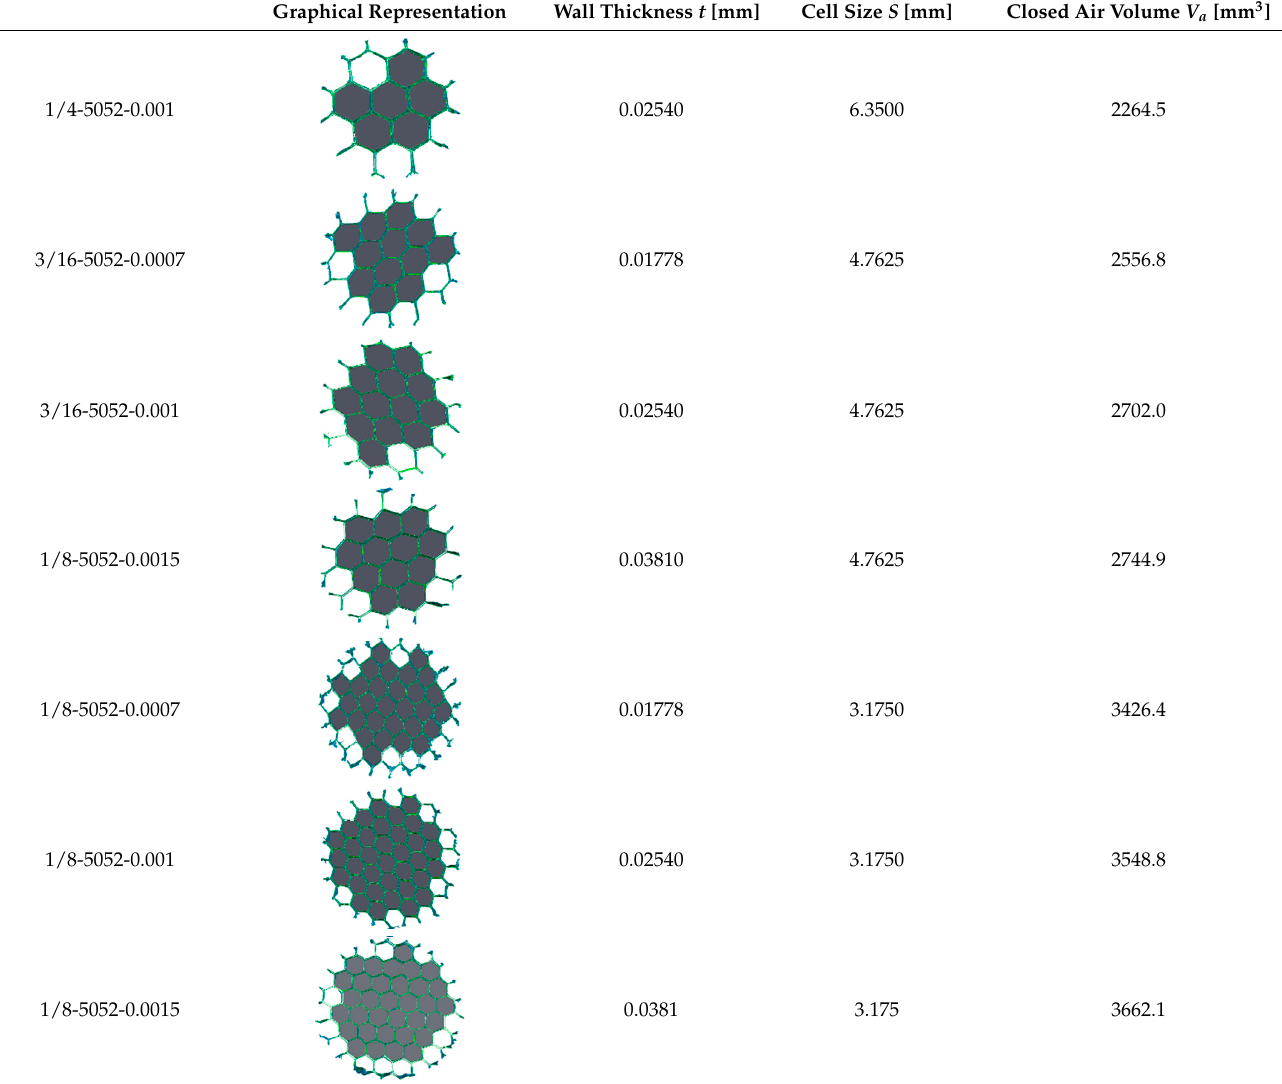
Figure 10. Increase in plateau stress depending on the volume of air trapped inside cells (based on results obtained in [21]). Table 4. Measurement results of the volume of air limited by walls in the real models of the samples. Graphical Representation